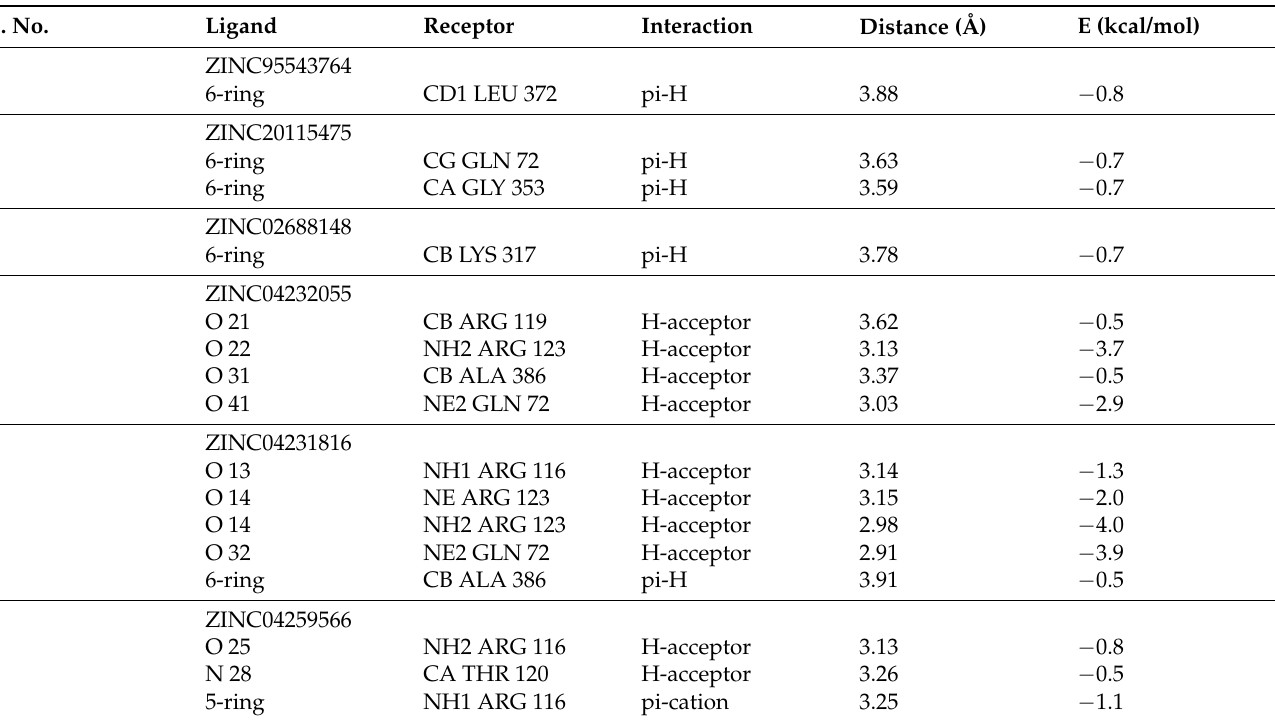
Table 2. Docking scores and identified bond types predicted through MOE tool for shortlisted compounds.